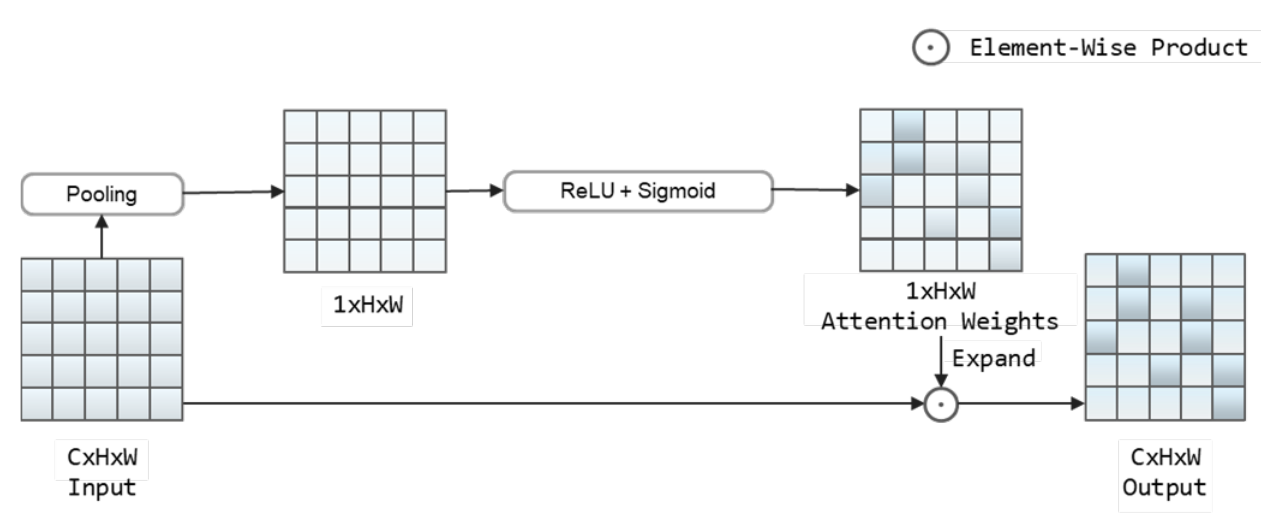
Figure 3. It shows the details of SAM. Spatial average pooling, Conv-ReLU and Conv-Sigmoid are used sequentially for the input feature map to obtain the attention weights. The attention weights are assigned to the input feature map through element-wise production.